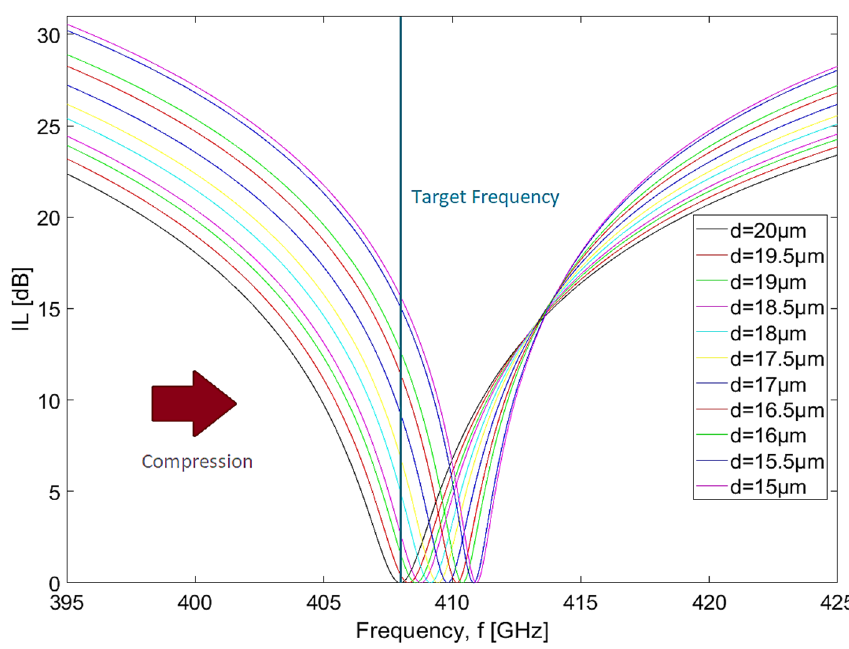
Figure 6. Insertion loss in the frequency domain as a function of applied compression for HDPE host